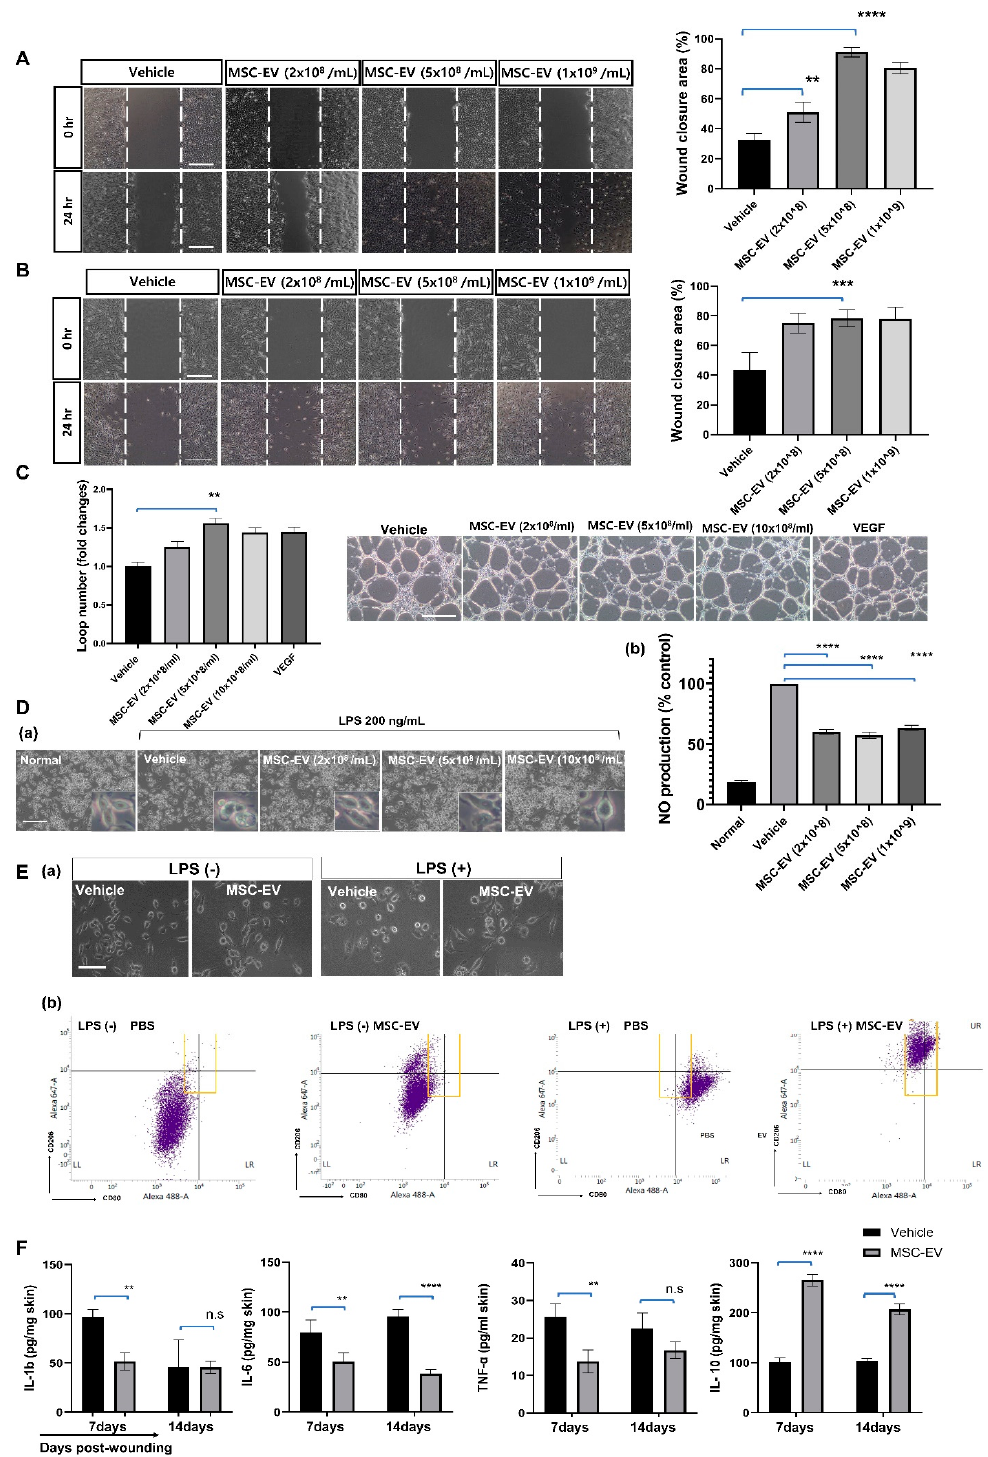
Figure 6. In vitro assay for MSC-EV effects on four major cell types involved in wound healing: keratinocytes, fibroblasts, endothelial cells, and inflammatory cells. ( A , B ) Scratch wound